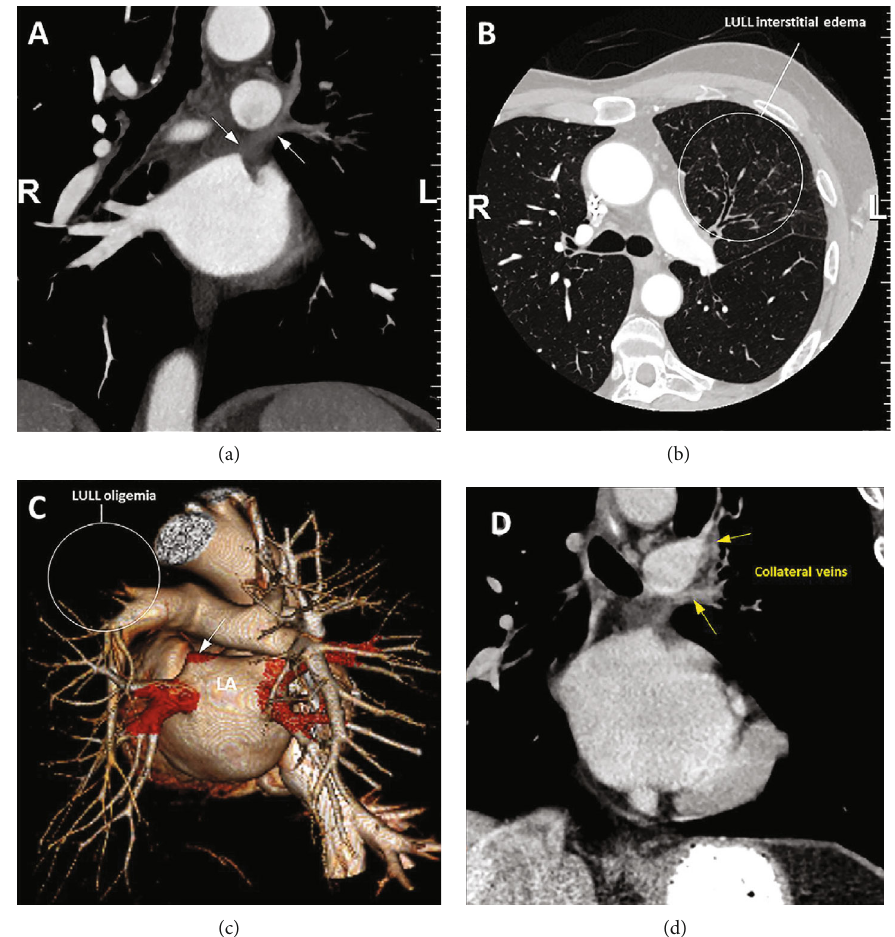
Figure 3: Coronal oblique view (a), axial view (b), and volume-rendered 3D reconstruction (c) from an arterial phase CT angiogram demonstrate absence or stump of the left superior pulmonary vein (white arrows) and left upper lobe oligemia ((c), circled) and chronic interstitial edema ((b), circled). Coronal oblique vascular reconstruction from a delayed venous phase CT angiogram (d) demonstrates small collateral draining veins (yellow arrows). LULL=left upper lung